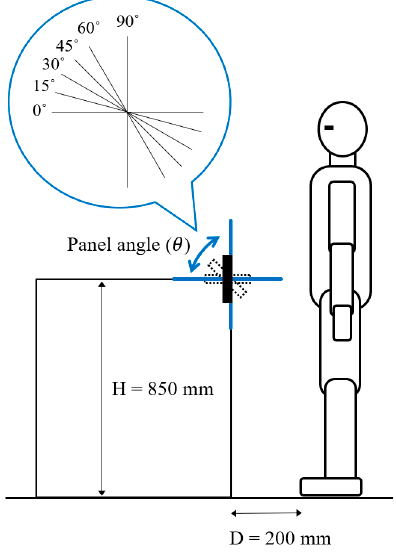
Figure 1. Experimental apparatus.